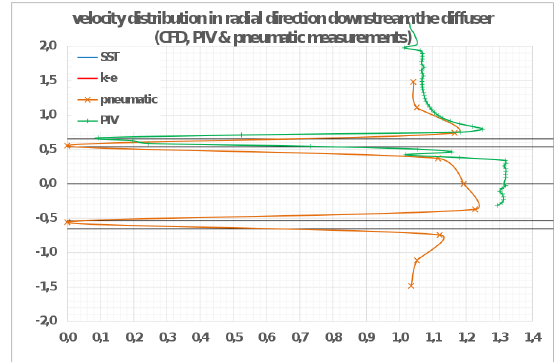
Figure 5: Velocity distribution downstream the diffuser at a distance x/D=1.1 (refer to Figure 4 for location)